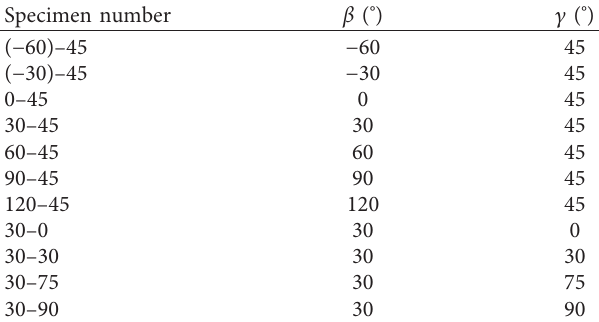
Table 1: List of sandy mudstone specimens with prefabricated cross-flaws.